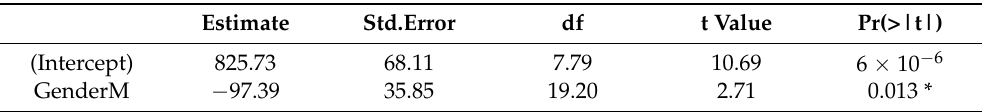
Table 4. Fixed effects of gender on F1.